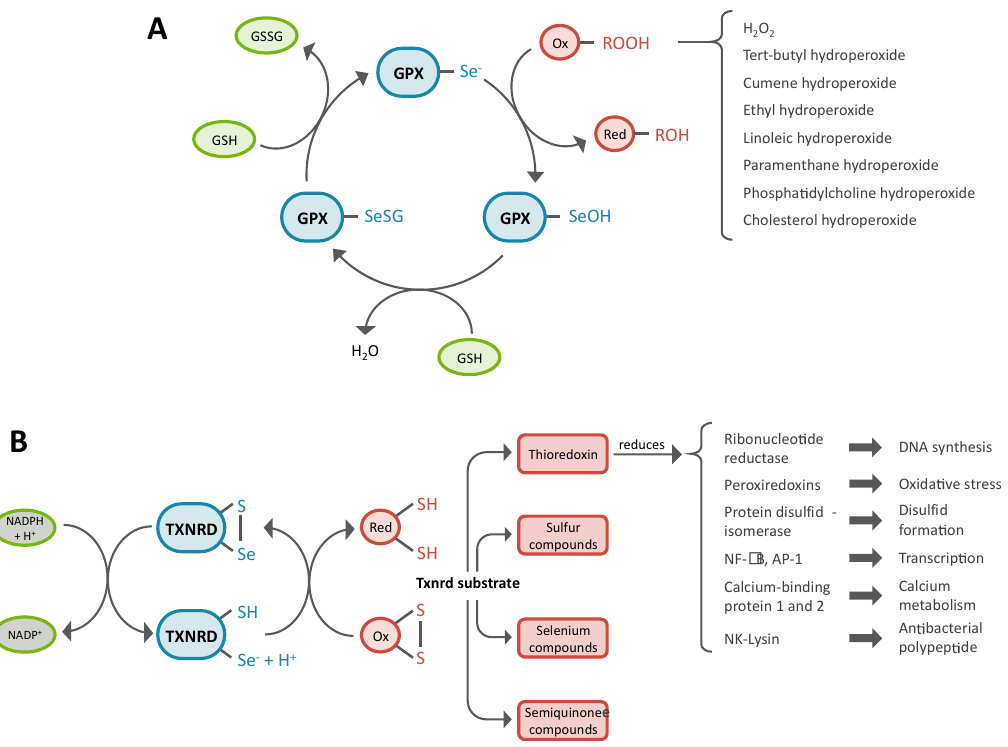
Figure 2. Enzymatic activities of the two most important families of selenoproteins involved in antioxidant defense in mammalian cells: the glutathione peroxidase (GPX) and the thioredoxin reductase (TXNRD). ( A ) GPXs use two molecules of reduced glutathione (GSH) to reduce hydrogen peroxides and organic hydroperoxides (ROOH) in their respective alcohols (ROH). The various peroxide substrates of mammalian GPXs are listed next to the bracket; ( B ) TXNRDs use NADPH to catalyze the reduction of thioredoxins and therefore participate in many cellular functions but can also reduce other sulfur or selenium containing compounds. Ox, oxidized molecule; Red, reduced molecule.